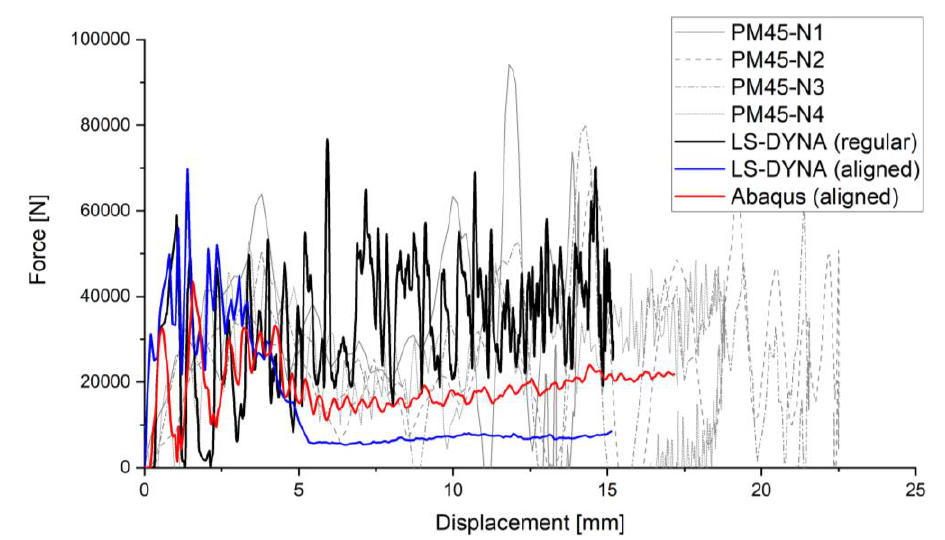
Fig. 5 . Predicted load vs. displacement curves compared with experimental